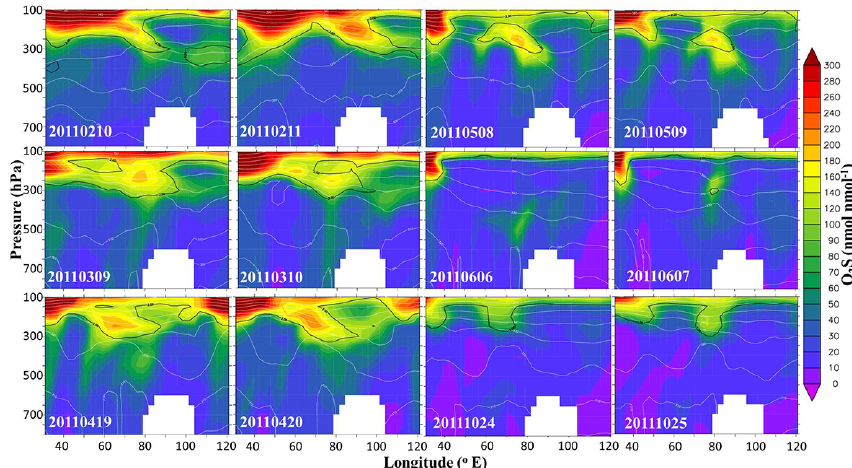
Figure 8. The longitude-pressure cross section of EMAC-simulated O 3 s at 29.5 ◦ N during all SOP days and a day before the event. White lines denote the potential temperature (K) and the black line denotes the dynamical tropopause at